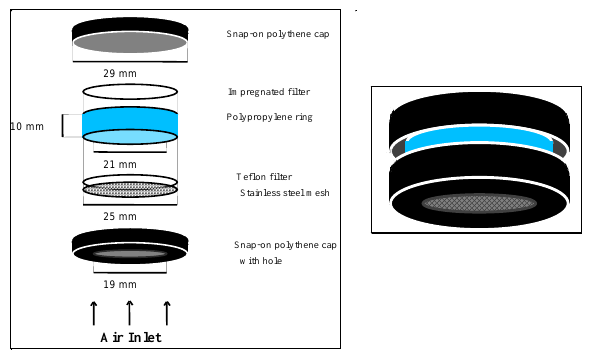
Figure 2: Diagram of the IDAF passive diffusion sampler (adapted from Ferm [1991]). Fig. 2. Diagram of the IDAF passive diffusion sampler (adaptation from Ferm,